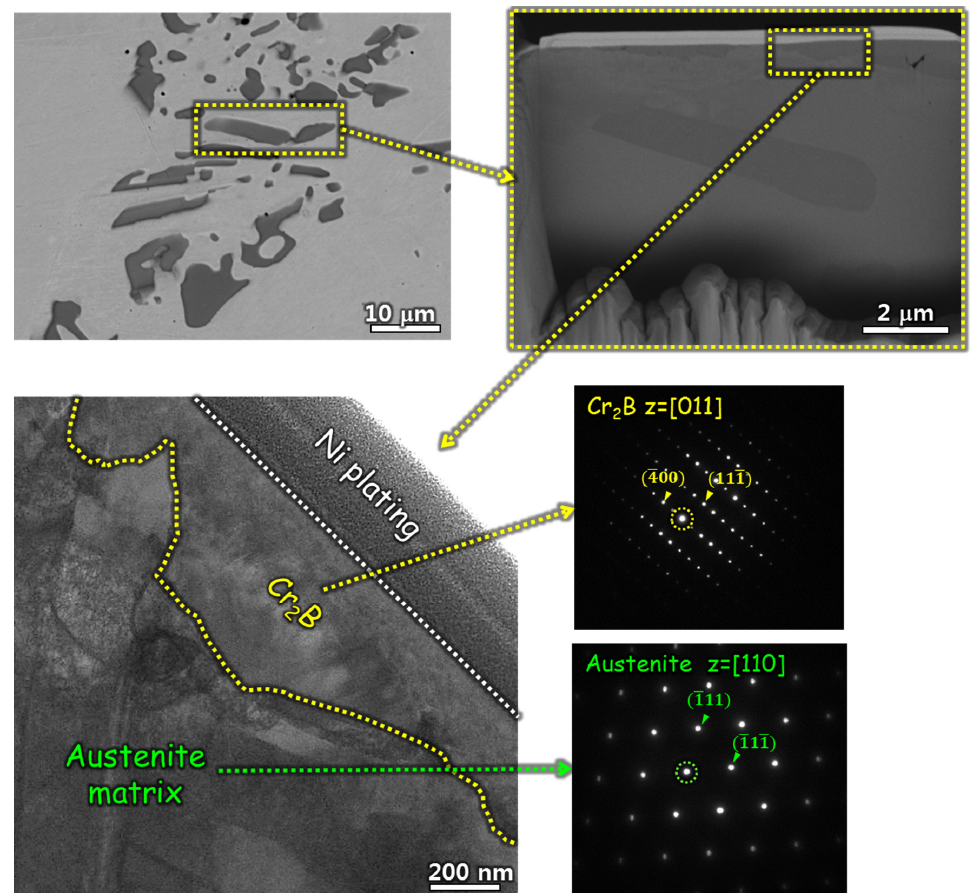
Figure 4. Procedure of focused ion beam (FIB) sampling, bright field (BF) imaging, and corresponding selected area diffraction (SAD) patterns of Cr 2 B and the austenite matrix taken from the B078 alloy.